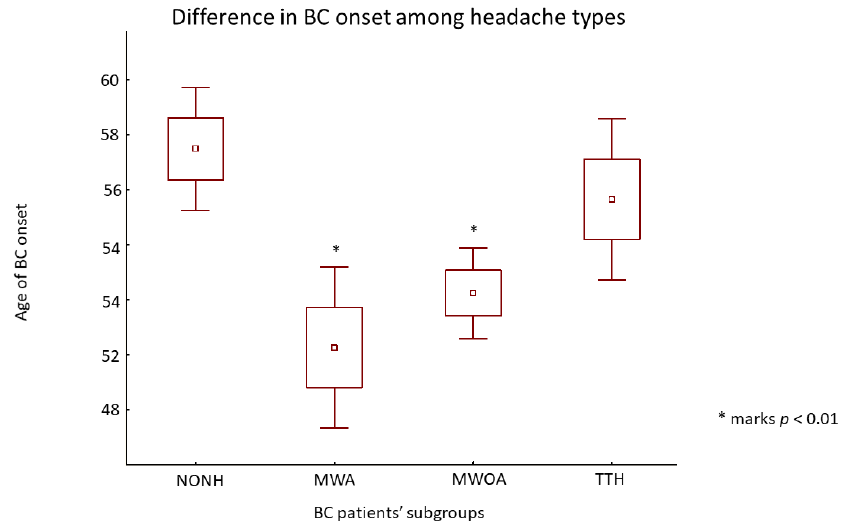
Figure 2. Age of BC development in relation to headache diagnosis.